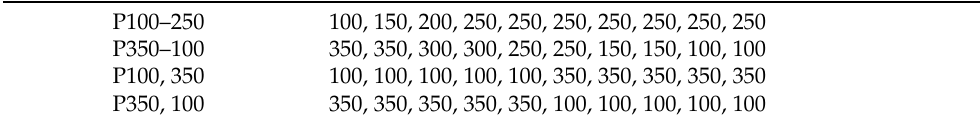
Table 4. Laser power [W] dependent on layer 1, 2, 3, 4, 5, 6, 7, 8, 9,